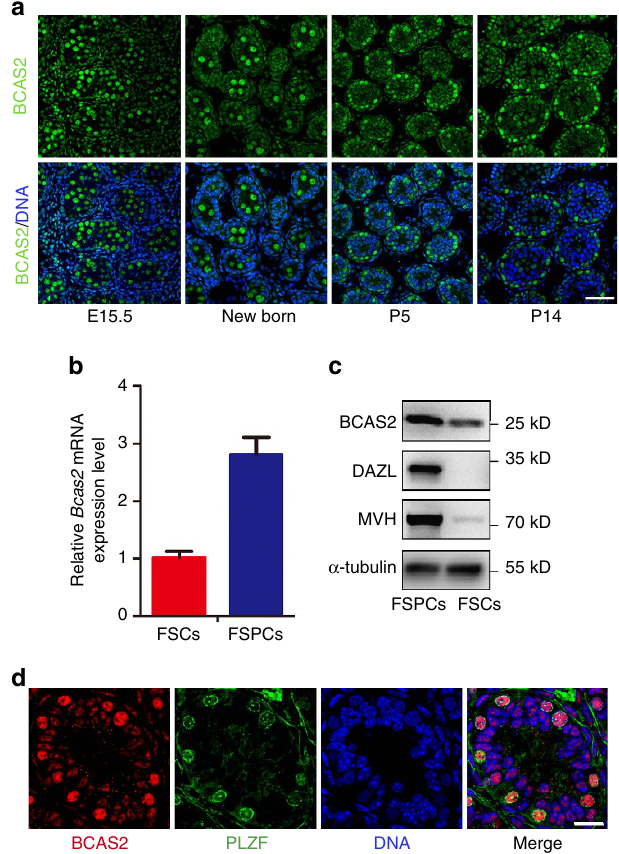
Figure 1 | Expression of BCAS2 in male mouse germ cells. ( a ) Immunofluorescence (IF) staining of BCAS2 in the paraffin sections of testes from E15.5 to P14 mice. The DNA was stained with Hoechst 33342. Scale bar, 50 m m. ( b ) Real-time PCR analysis of Bcas2 expression in the fraction of spermatogenic cells (FSPCs) and the fraction of somatic cells (FSCs) enriched from P9 testes. Gapdh was used as the internal control for analysis of BCAS2 expression in the fraction of spermatogenic cells (FSPCs) and the fraction of somatic cells (FSCs) enriched from P9 testes. Germ cell markers (DAZL and MVH) were used as the indicator of the enrichment efficiency and a -tubulin was used as the loading control. ( d ) Paraffin sections of P8 testes were co-stained with rabbit anti-BCAS2 and mouse anti-PLZF antibodies. The DNA was stained with Hoechst 33342. Scale bar, 20 m m. NATURE COMMUNICATIONS|8:14182|DOI: